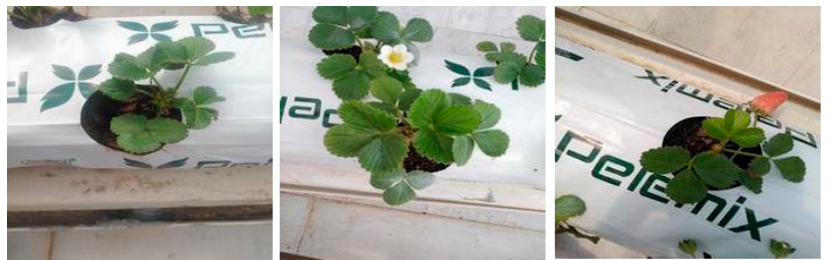
Figure 2. Three healthy photos (seedling, flowering, and crop) of the strawberry plant used in the dataset.